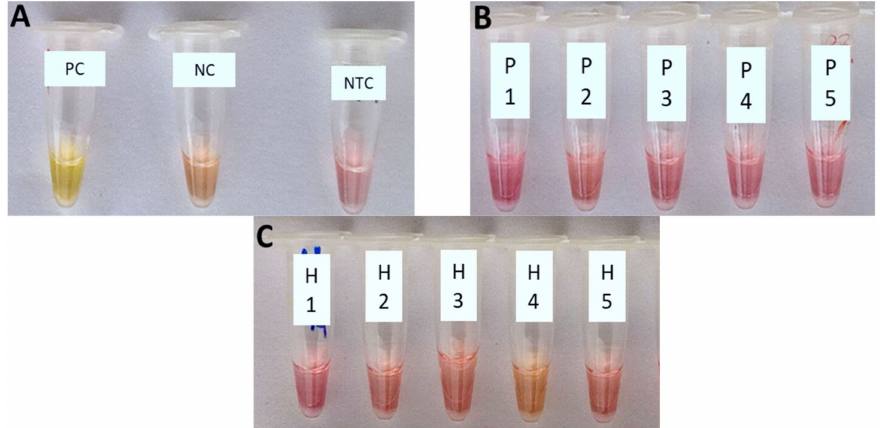
Figure 2. The cLAMP reactions. ( A ) PC (positive Xfp control): bacterial suspension of Xylella fastidiosa subsp. pauca strain ‘De Donno’ (approx. 10 5 CFU/mL); NC (negative control): healthy olive sap; NTC : No-Template Control; non-target bacteria spiked in PBS 1X ( B ) and healthy olive crude sap ( C ). 1 : Rahnella aquatilis ; 2 : Escherichia coli BL21(DE3); 3 : Paraburkholderia phytofirmans strain PsJN ; 4 : Pseudomonas marginalis ; 5 : Xanthomonas campestris pv. campestris